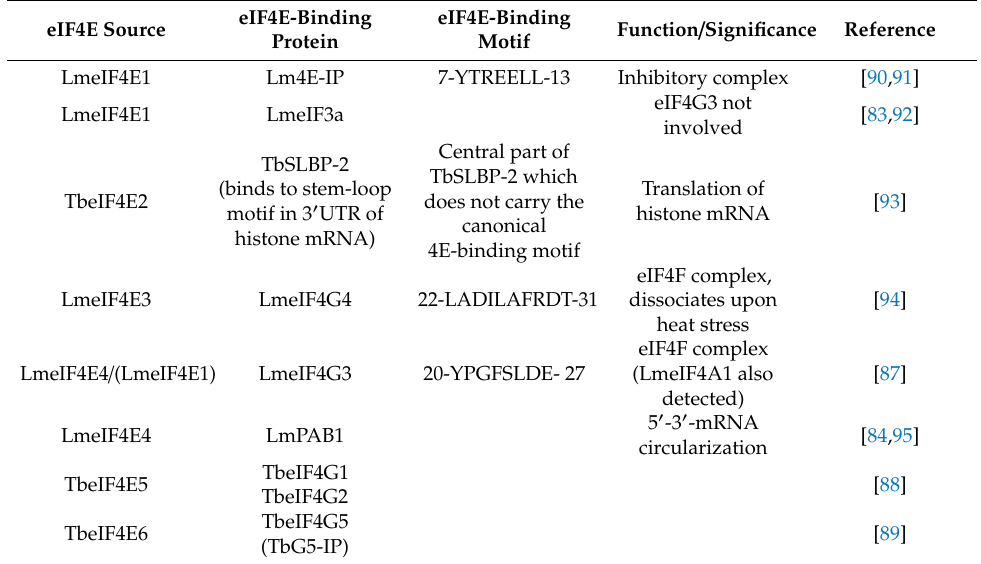
Table 1. Summary of reported Trypanosomatid eIF4E-interactions from Leishmania major (Lm) and Trypanosoma brucei